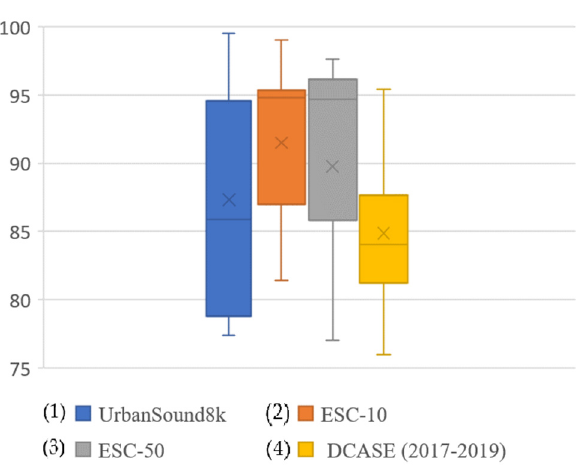
Figure 11. Summary of performance metrics (accuracy) based on most popularly used sound datasets: (1) Urbansound8k, (2) ESC-10, (3) ESC-50, and (4) DCASE datasets from 2017 to 2019.